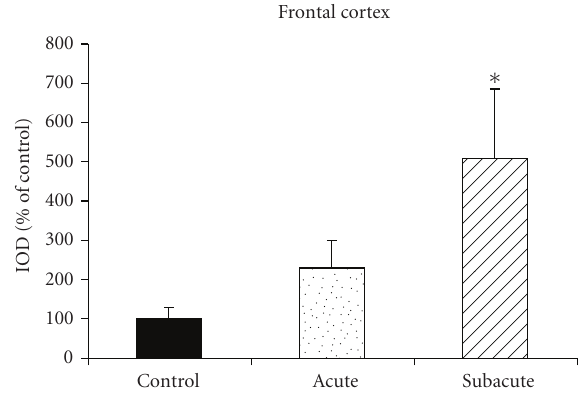
Figure 2: Expression of NMDAR1 in frontal cortex. Data are integrated optical density of NMDAR1 immunoreactivity band, normalized to β -actin levels and expressed as percentage of the control group. Values represent mean ± S.E.M ( n = 5–7). ∗ P < . 05 in comparison with the control group by one-way ANOVA with Dunnett post-hoc test.